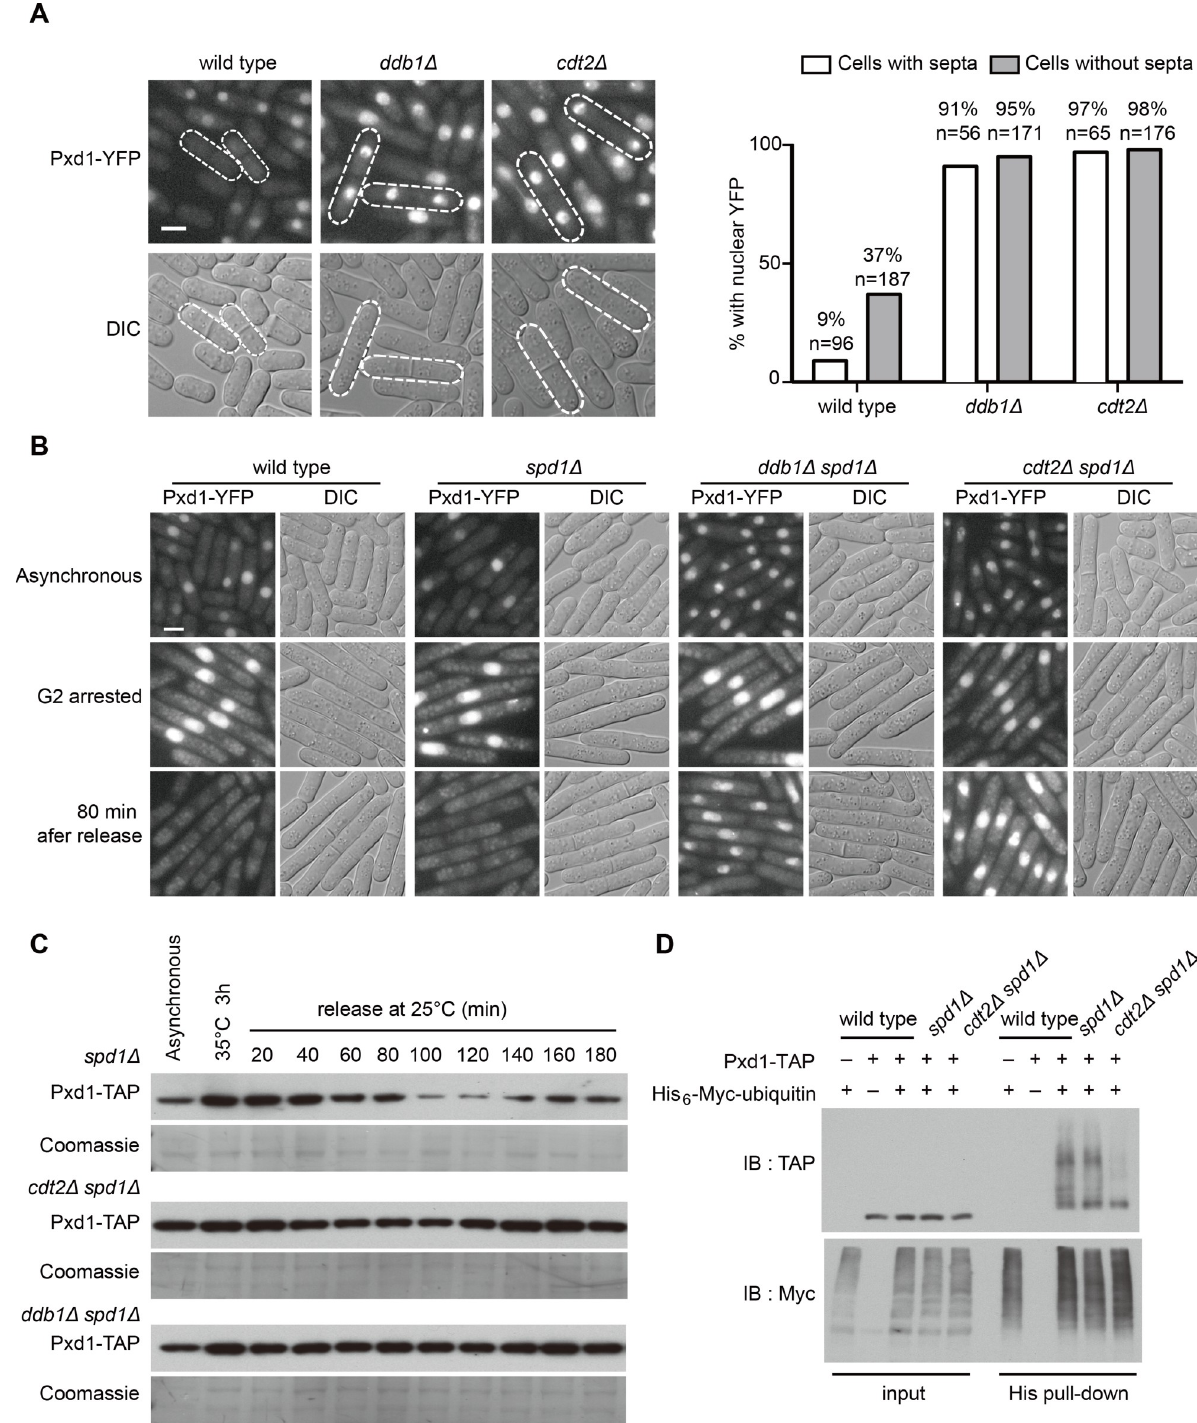
Fig 2. CRL4 Cdt2 mediates the ubiquitination and degradation of Pxd1 in S phase. (A) Micrographs (left) and quantitation (right) showing that the fluorescence signal of Pxd1-YFP was visible in nearly all cells in asynchronous cultures of ddb1 Δ and cdt2 Δ mutants. Cells with septa are marked. n, the number of cells used for the quantitation of Pxd1-YFP. (B) The fluorescence signal of Pxd1-YFP in asynchronous cells, cells arrested in G2 by cdc25-22 , and cells released back into the cell cycle for 80 min. See S2A Fig for quantitation. (C) The protein level of Pxd1-TAP in cells synchronized by cdc25-22 arrest and release. (D) The ubiquitination of Pxd1 is dependent on the CRL4 Cdt2 E3 ligase. Ubiquitinated proteins were enriched under denaturing condition using Ni-NTA beads. His 6 -Myc-tagged ubiquitin and Pxd1-TAP were detected by immunoblotting (IB). Bars, 3 μ m.